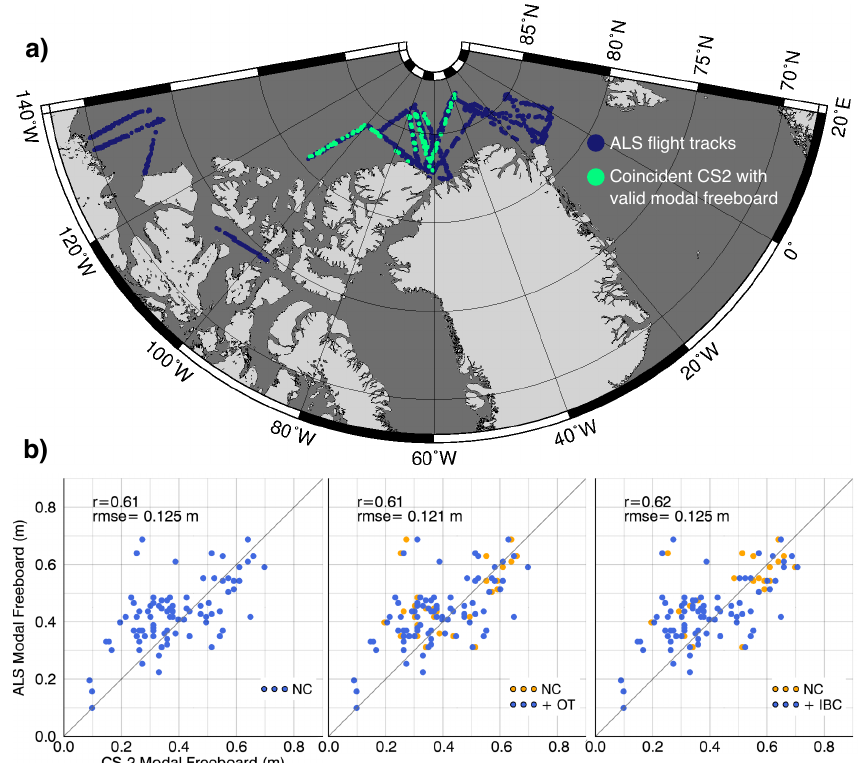
Figure 2. ( a ) CryoSat-2 validation flight tracks during 2011–2014, where airborne laser scanner (ALS) measurements have been carried out. ALS measurements and co-located CryoSat-2 measurements are averaged on a 10 × 10 km grid. Green dots highlight grid cells where both CryoSat-2 and ALS modal freeboard are valid; ( b ) Scatterplots of CryoSat-2 modal freeboard against ALS modal freeboard (blue dots) with corresponding correlation coefficient ( r ) and root mean square error ( rmse ). The left plot shows CryoSat-2 modal freeboard without any corrections (NC), in the center plot the Ocean Tides (OT) correction is applied, while in the right plot the inverse barometric correction (IBC) is switched on. The orange dots reveal the CryoSat-2 modal freeboard without applying the